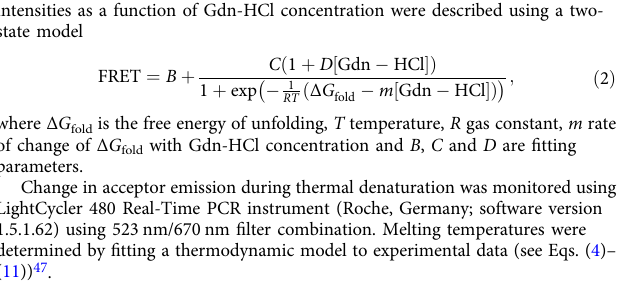
Fluorescent labelling . Proteins were fl uorescently labelled with Sulfo-cy3 and Sulfo-cy5 (Lumiprobe, MD, USA) via thiol-maleimide coupling. Sulfo-cy3 and Sulfo-cy5 were dissolved in DMSO, mixed together and added in 5-times molar excess to approximately 1mL of 1 mg/mL protein solution in Tris buffer (20 mM Tris at pH 7.5, 150 mM NaCl) with 1 mM TCEP. The reaction was allowed to proceed over night at 4 °C. The reaction mixture was puri fi ed on a PD 10 dis- posable desalting column (GE Healthcare, IL, USA), using Tris buffer as mobile phase. Peptide labelling reactions were performed by mixing 100 nmol of peptide dissolved in 100 μ L of labelling buffer (50 mM Tris, 150 mM NaCl, 1 mM TCEP, 5 mM EDTA, pH = 7.2) with 300 μ L of DMSO and adding 50 μ L of 13mM dye solution (in DMSO). The reaction was allowed to proceed for two hours at room temperature, protected from ambient light. The labelled peptide was isolated from the reaction mixture with reverse phase HPLC using a Jupiter 4 μ m Proteo 90 Å column (Phenomenex, CA, USA). Separations were performed with two buffer systems. For P7SN-cy3 and APHSN-cy3 phase B (95% ACN, 5% H 2 O, 0.1% TFA) was non-linearly increased from 0 to 80% in 26 min (phase A: 5% ACN, 95% H 2 O, 0.1% TFA, Supplementary Table 14a). For other peptide-dye conjugates phase B (95% ACN, 5% H 2 O) was increased from 0 to 80% in 36 min (phase A: 5 % ACN, 95% 0.1M TEAA pH = 7, Supplementary Table 14b). After isolation peptides were exchanged into buffer (50 mM Tris, 150 mM NaCl, pH = 7.5). Concentration was determined spectrophotometrically from dye absorbance purity of the isolated peptide-dye conjugates were con fi rmed by matrix-assisted laser desorption/ionization time-of- fl ight mass spectrometry (MALDI-TOF). Matrix-assisted laser desorption/ionization time-of- fl ight mass spectrometry (MALDI-TOF) . Bruker Ultra fl eXtreme MALDI-TOF mass spectrometer (Bruker Daltonics, Bremen, Germany) was used to perform mass spectrometry experi- ments. Prior to the measurements, each peptide-dye sample was combined in 1:1 volumetric ratio with a saturated solution of sinapinic acid dissolved in acetonitrile and 0.1% tri fl uoroacetic acid (7:3, v/v). Using the dried-droplet method, 1 μ L of the sample was then spotted on the target plate. The mass spectra of the peptide-dye samples were recorded in the re fl ective positive ion mode. External calibration was performed using peptide calibration standards and protein calibration standards I (Bruker Daltonics). Förster resonance energy transfer (FRET) stopped- fl ow . Labelled CCPO cages were unfolded by adding 478 mg of guanidine hydrochloride (Gdn-HCl) into 1mL of protein samples at a concentration of ~1 mg/mL resulting in Gdn-HCl fi nal concentration of ~5 M. Coiled-coil forming peptide-dye conjugates were mixed in 1:1 ratio resulting in 20 μ M dimer concentration. Subsequently, Gdn-HCl was added to solutions to achieve a fi nal concentration of 5 M. The samples were left for one hour at room temperature to ensure complete unfolding. The measurements were performed on MOS-200 spectrometer with an SFM- 3000 stopped fl ow unit (BioLogic, France). Data was collected with Bio-Kine32 software (version 4.72.). Total fl ow was set to 6mL/s (estimated dead time 3.7ms) or 11.5 mL/s (dead time 1.9 ms). Folding of CCPO cages was triggered by mixing at least 30µL of sample against 4 volumes of Tris buffer (20 mM Tris, 150 mM